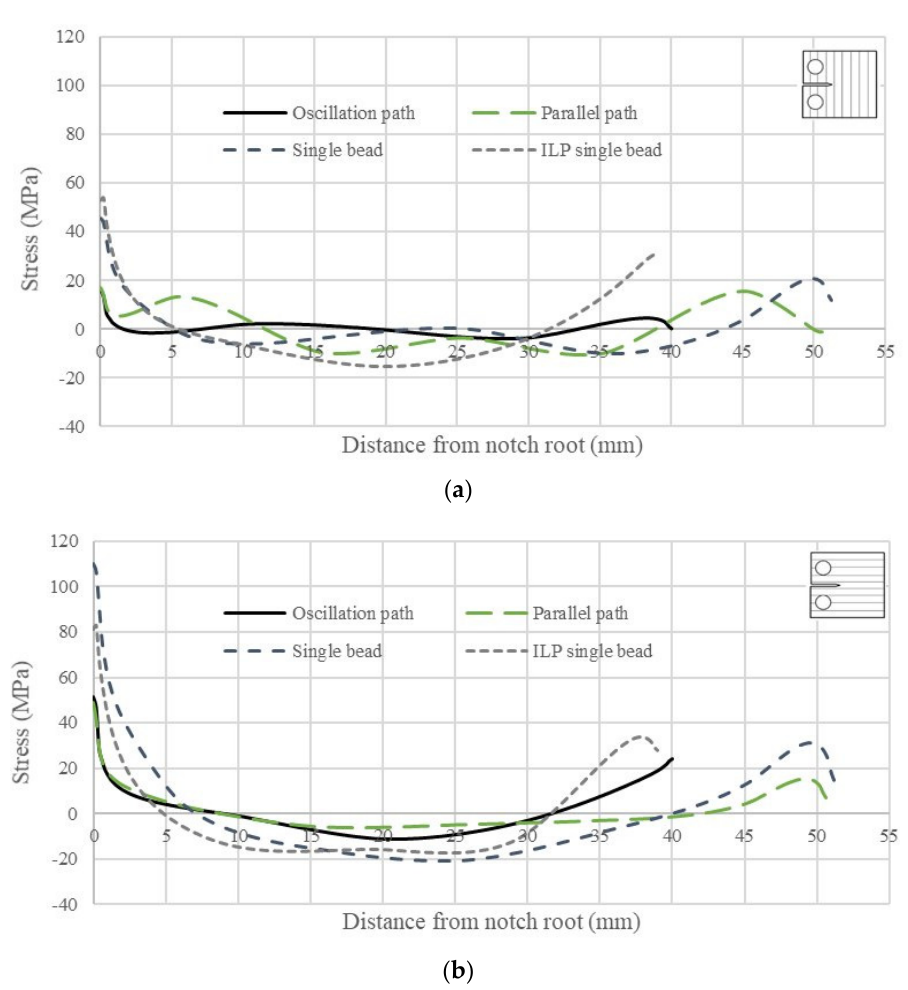
Figure 9. Through-thickness averaged residual stress profiles from the compact-tension (C(T)) coupons: ( a ) crack across the layers, ( b ) crack parallel to layers.